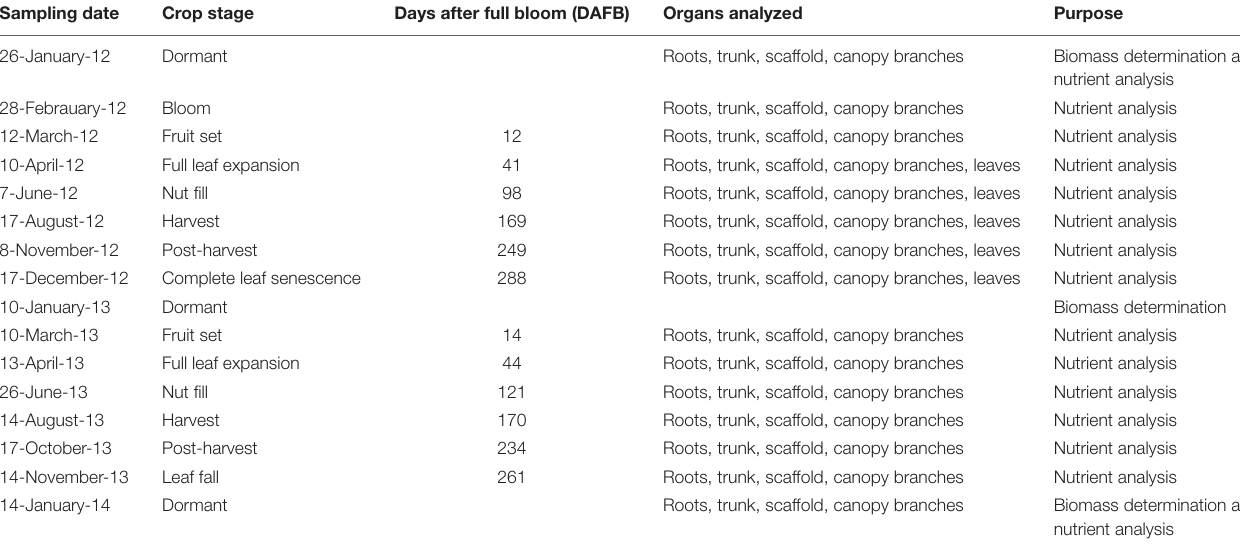
TABLE 1 | Sampling dates, crop stage, day after full bloom, and organs sampled for almond